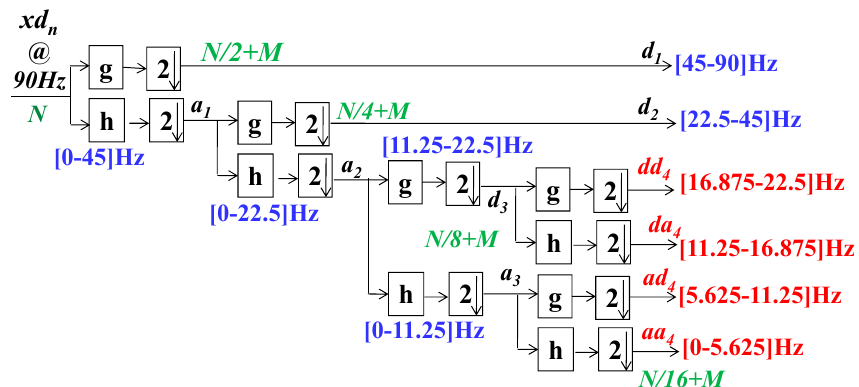
Figure 3. The employed wavelet decomposition scheme.